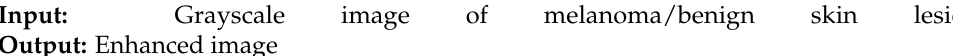
Algorithm 3 Similarity Coefficient